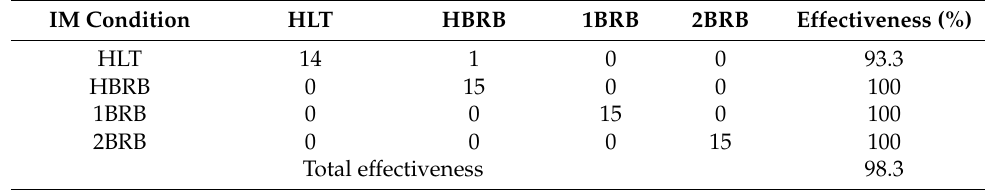
Table 6. Classification results (confusion